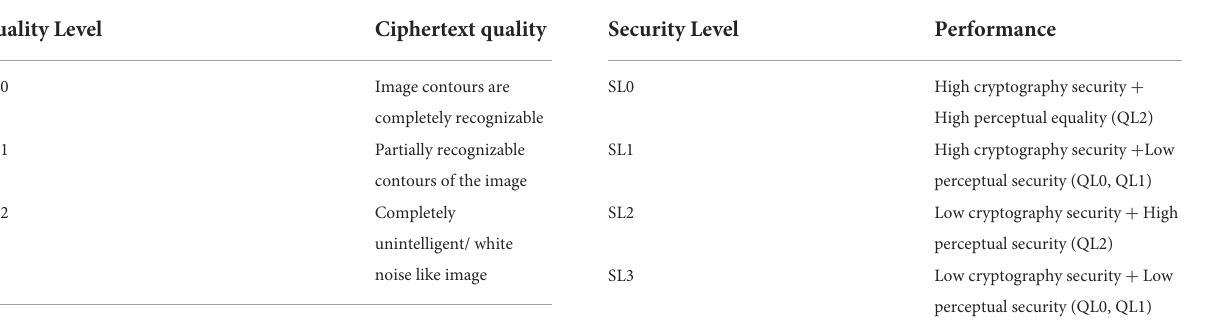
TABLE 6 Subjective metrics for perceptual security analysis. TABLE 7 Evaluation of encryption